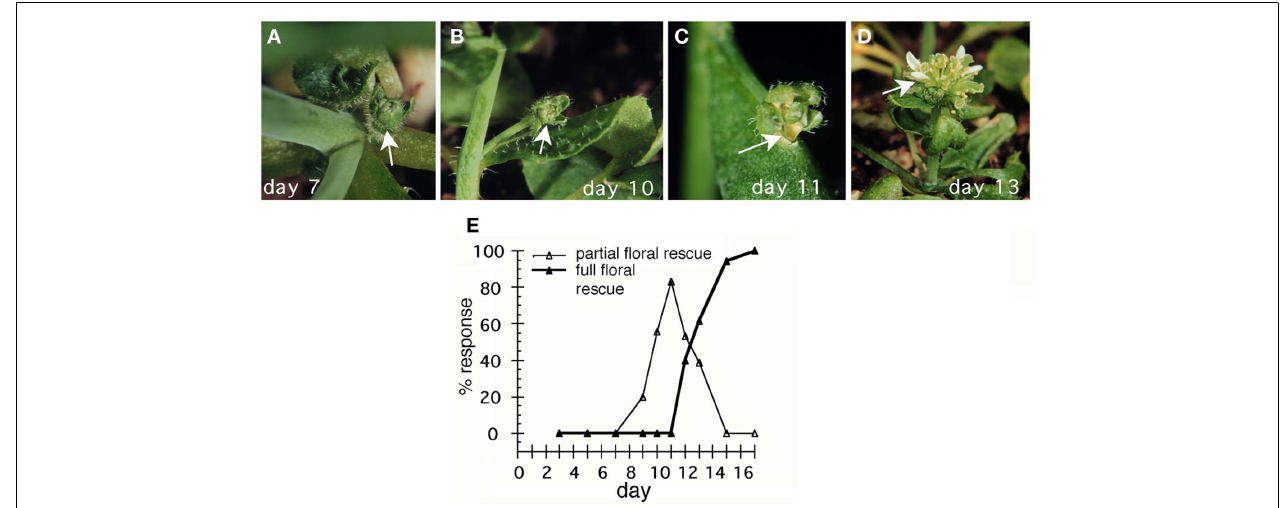
FIGURE 2 | Effect of transient LFY activation on floral organ identity. lfy-6 35S:LFY-GR plants were treated as described in Figure 1 on day 7 (A) , day 10 (B) , day 11 (C) , and day 13 (D) .The axillary (A) or secondary (B–D) flowers that formed in response to dexamethasone treatment were examined for rescue of the lfy-6 floral homeotic defects. Activation on day 7 resulted in formation of lfy-6 flowers (A) .Treatment on day 10 or day 11 caused partial